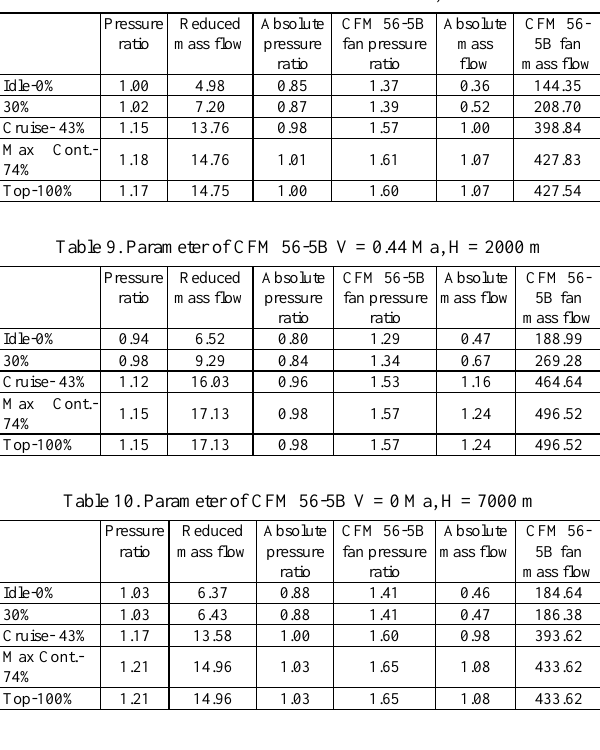
Table 8. Parameter of CFM 56-5B V = 0.2 Ma, H = 2000 m